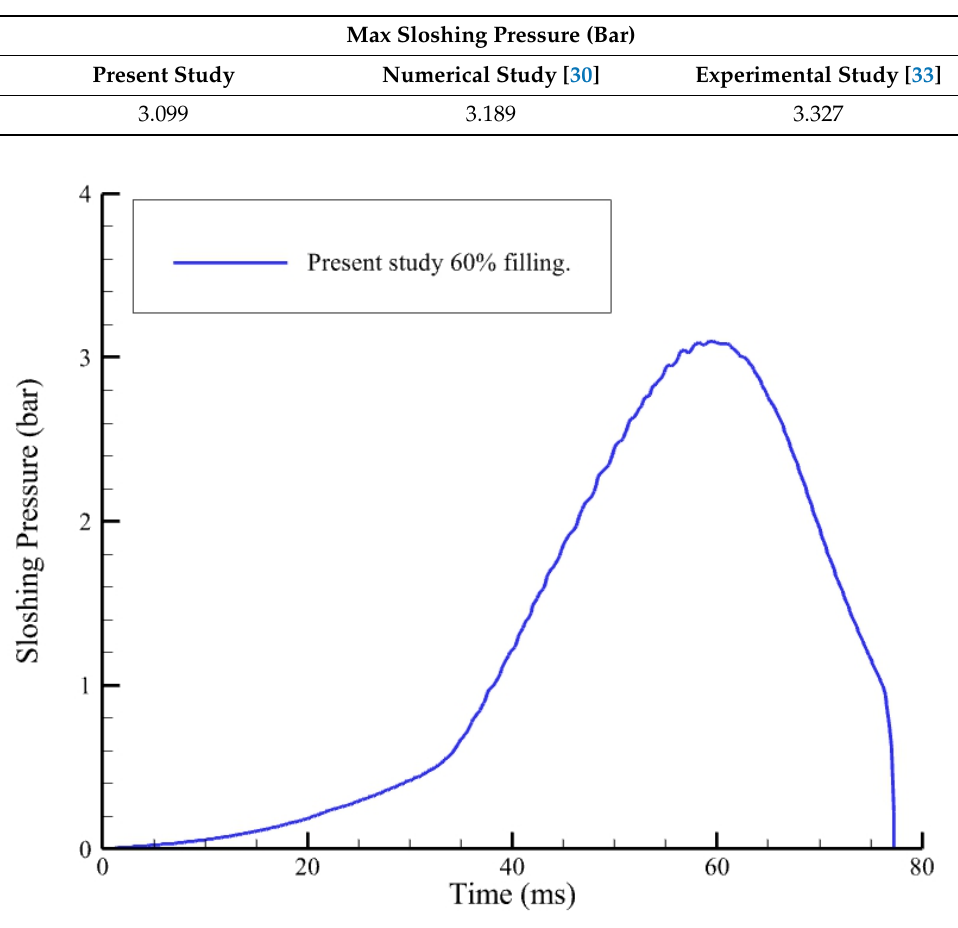
Table 2. Comparison of the max sloshing pressure of unbaffled rectangular tank under 60% filling ratio in the present result and numerical and experimental results from literature.